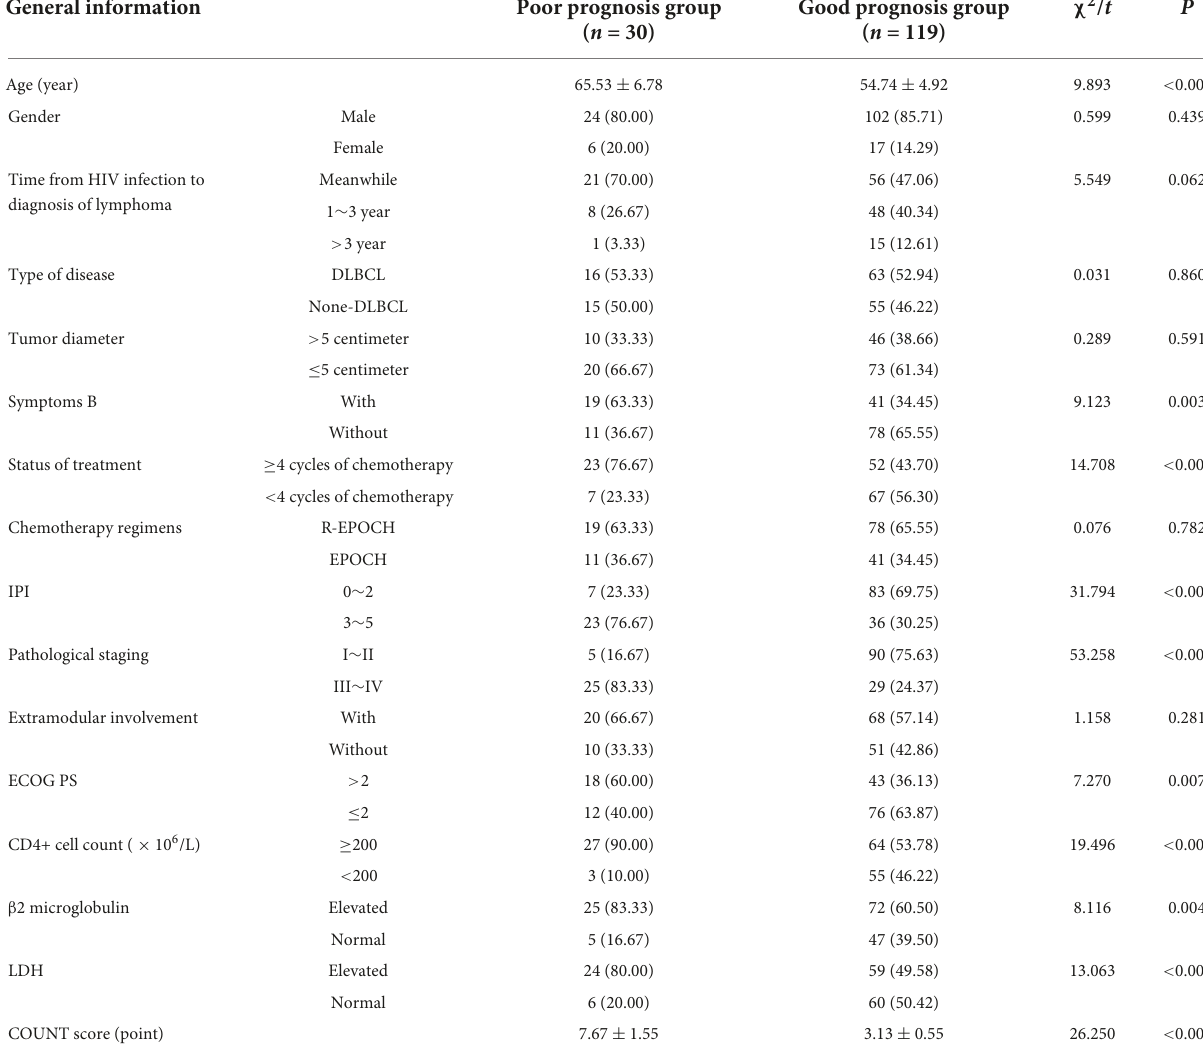
TABLE 2 Comparison of clinical data between the poor prognosis group and the good prognosis group. General